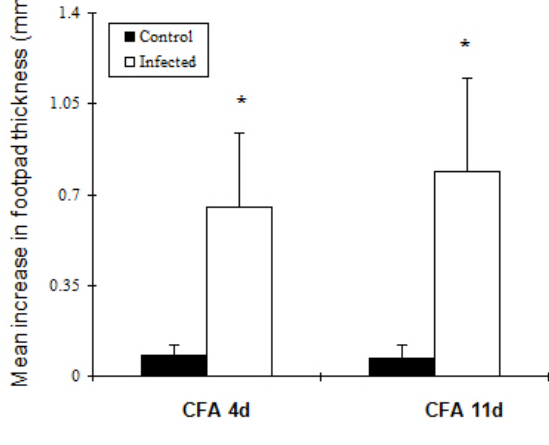
Figure 1. Comparison between reactions induced by 4d and 11d CFAg. Fifteen days after infection with 5 x 10 6 P. brasiliensis yeast cells by IP route, mice were injected in the footpad with CFA 265 (50 mg/50 mL) obtained from 4-day or 11-day-old culture. After 24 hours the increase in the footpads was determined. The bars depict the mean of six animals ± SD. * Significantly different (p < 0.01) from control